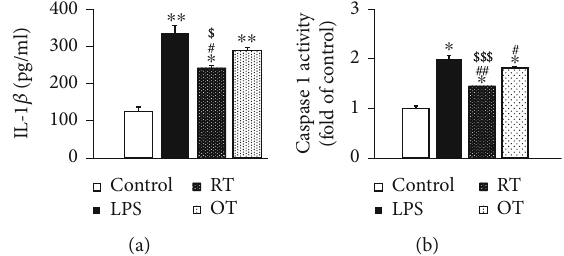
Figure 4: AEA reduced IL-1 β secretion and caspase 1 activity in LPS-stimulated AGS cells. E ff ect of LPS and AEA on the (a) secretion of IL-1 β and (b) activity of caspase 1. All experiments were performed in triplicate, and the results were obtained from at least two independent experiments. Data are expressed as means ± SEM . ∗ Indicates signi fi cantly changes compared to control group, ∗ p < 0 : 05 , and ∗∗ p < 0 : 1 ; # compared to LPS group, # p < 0 : 05 , and ## p < 0 : 01 ; $ compared to OT group, $ p < 0 : 05 , and $$$ p < 0 : 001